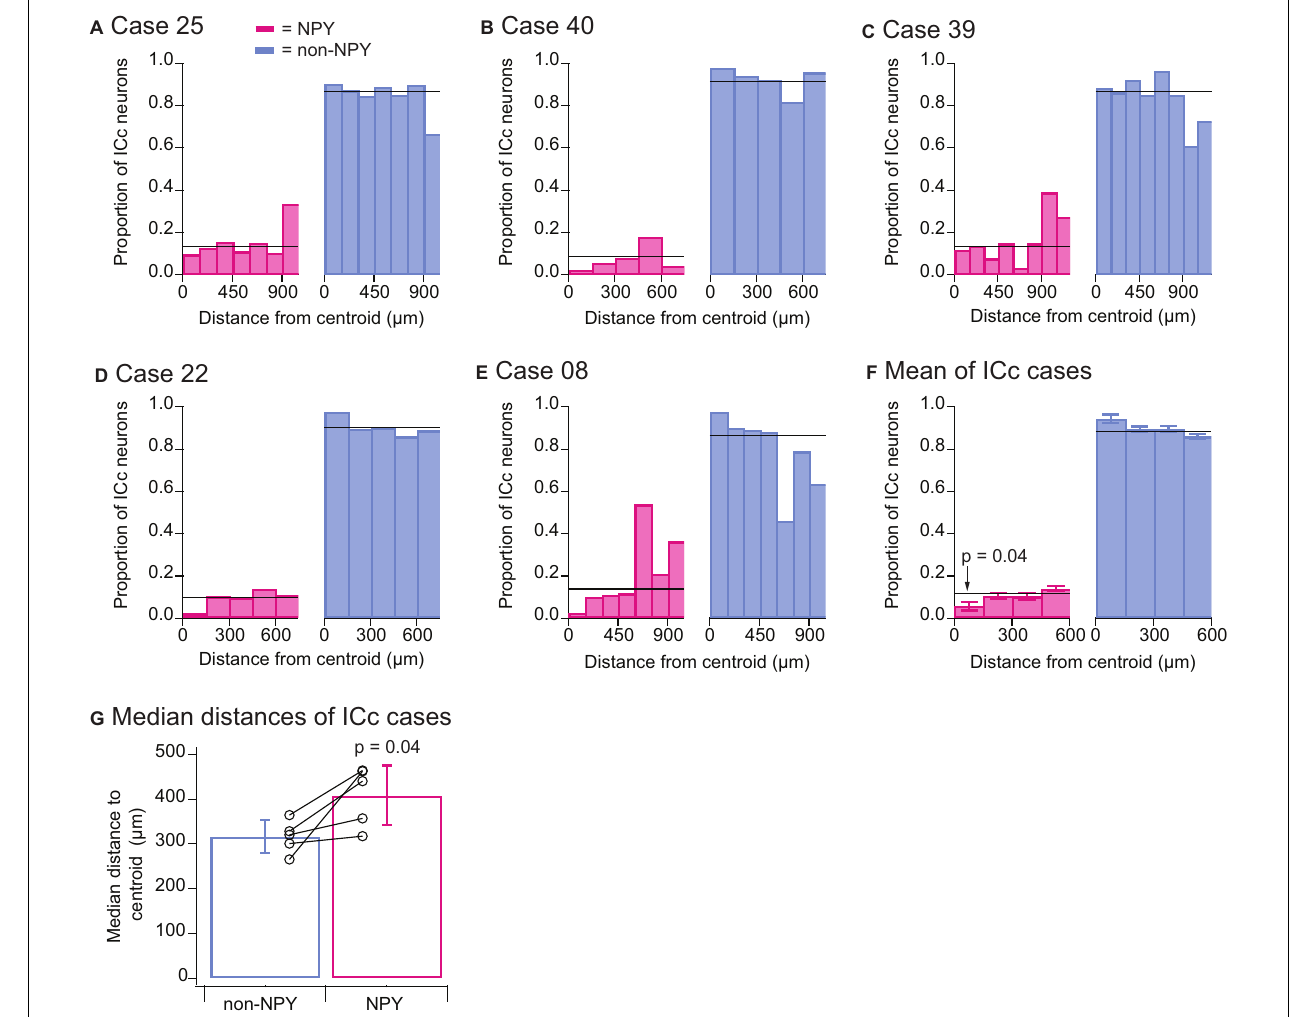
FIGURE 6 | Quantitative analysis confirms that the commissural projections of NPY neurons in the ICc are more heterotopic than those of non-NPY neurons. For each of the ICc injection cases, reconstructions of coronal sections of the left IC were aligned, the site in the left ICc homotopic to the centroid of the injection site in the right IC was mapped, and the three-dimensional distances of RB-labeled non-NPY and NPY neurons to the homotopic centroid were measured. RB-labeled neurons in the ICd and IClc were excluded from this analysis. (A–E) Distances to the centroid were sorted into 150 µ m bins, and the relative proportion of RB-labeled NPY (magenta, left) and non-NPY neurons (cyan, right) in each bin was plotted. The overall proportions of NPY and non-NPY neurons in the ICc for each case are plotted as black horizontal lines superimposed on the histograms. (F) Summary analysis of the data for the first four bins (representing 0–600 µ m) from the results shown in (A–E) . A two-tailed t -test comparing the 0–150 µ m bin in the NPY plot to the mean overall proportion of NPY neurons yielded a p -value of 0.04 (see “Results” Section for details). Bars indicate mean ± SEM, and horizontal lines represent the overall mean proportions of RB-labeled NPY and non-NPY neurons in the ICc across the five ICc cases. (G) Comparison of the median distances to the homotopic centroid from each ICc injection case also showed that NPY neurons were located farther from the homotopic centroid than non-NPY neurons (paired two-tailed t -test, see “Results” Section for details). Bars indicate mean ± SD of the median